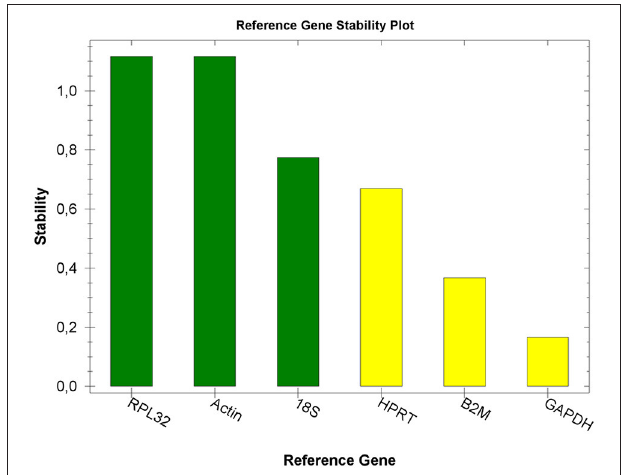
FIGURE 1 | Reference gene stability plot. Expression stability values (M) of six putative reference genes tested in placental tissues. Transcripts are ranked from the most stable to the least stable (left to